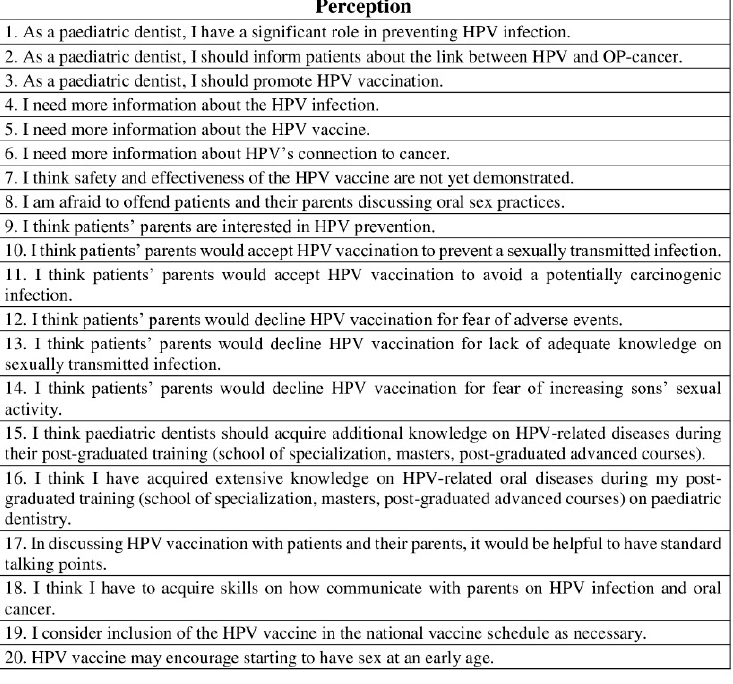
Figure 4. Questionnaire assessing pediatric dentists’ perceptions on HPV-related OP-cancer,